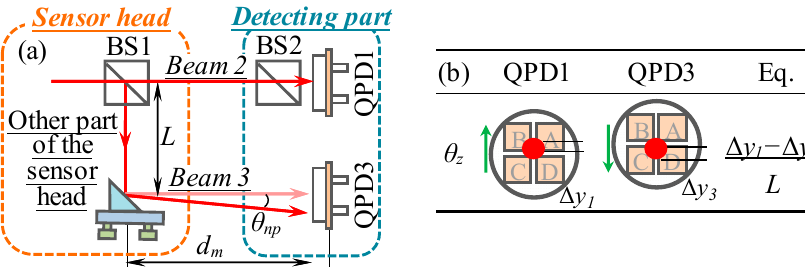
Figure 4. Measurement principle of the roll angular error: ( a ) Optical layout of roll angular error measurement kit, ( b ) variations of laser beam positions on QPDs.